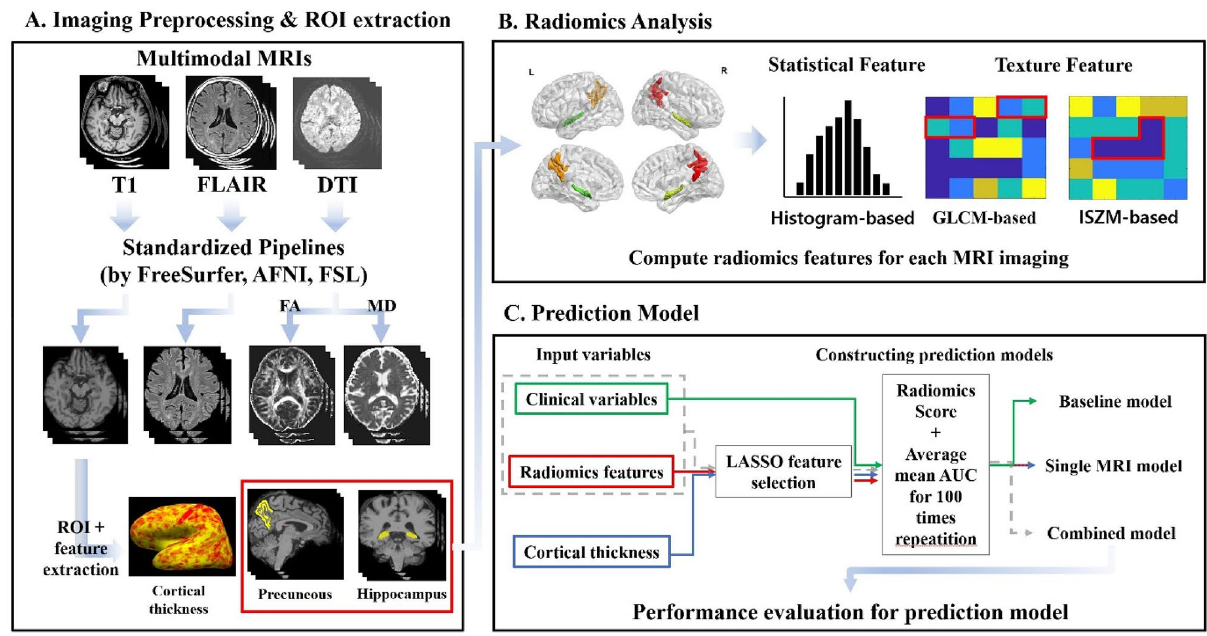
Figure 2. Overview of image processing and modeling. Schematic figures of image preprocessing and ROI extraction pipeline ( A ), radiomics analysis within precuneus and hippocampal ROIs ( B ), prediction model development using clinical and imaging features ( C